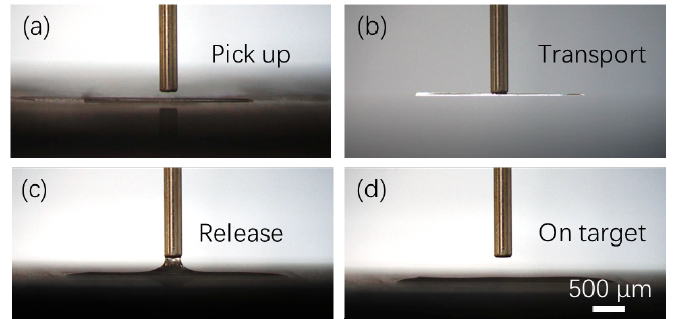
Figure 7. T Sequences of surface tension-based alignment of a glass fiber: ( a , b ) The needle picks up a microfiber and transport it to the target groove; ( c ) The needle generates a 10 nL water droplet and the droplet is in contact with the groove forming a water meniscus; ( d ) The water in the groove evaporates and the fiber is aligned with the